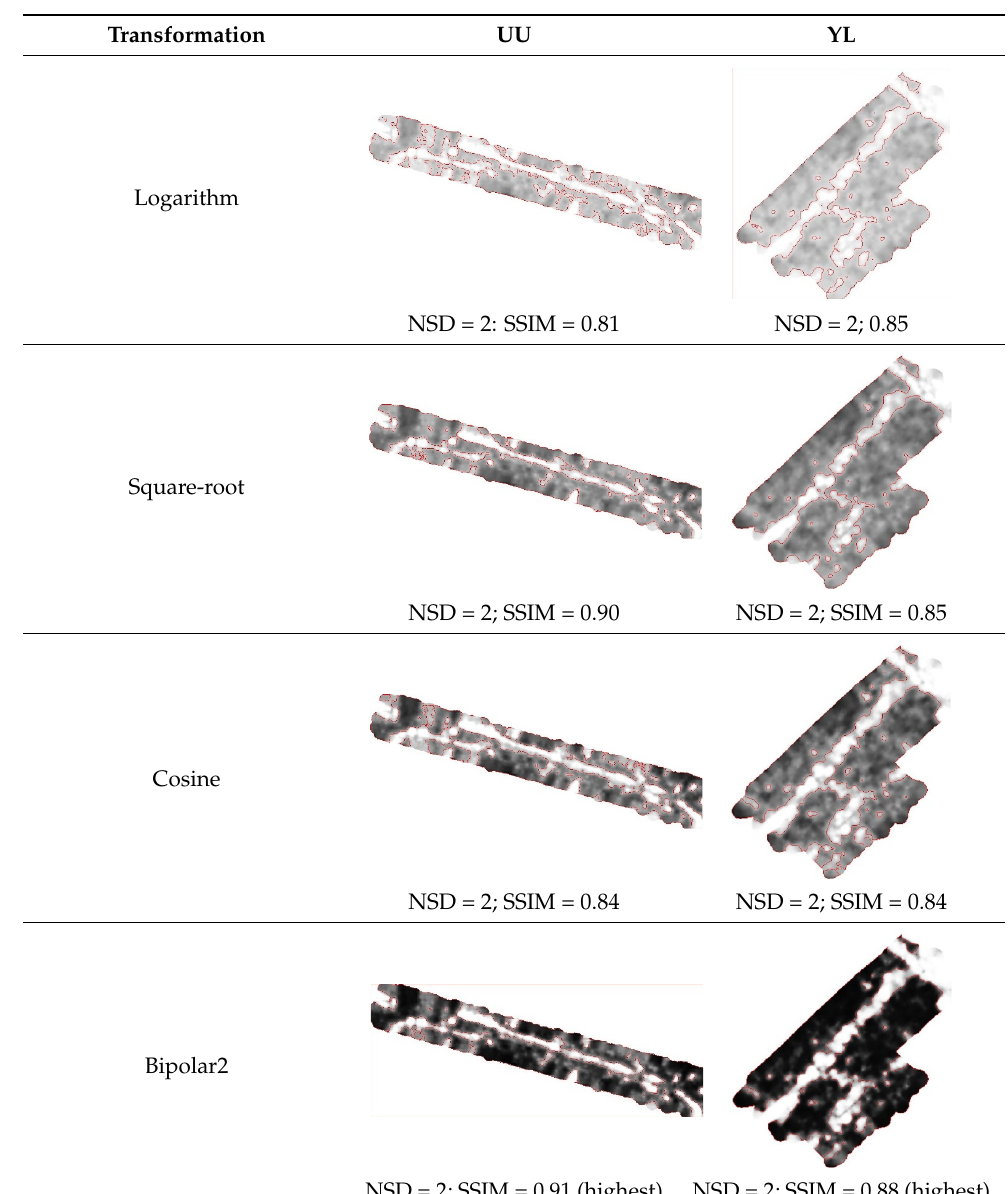
Table 6. Visualisation results of reinforced concrete structure cases with different